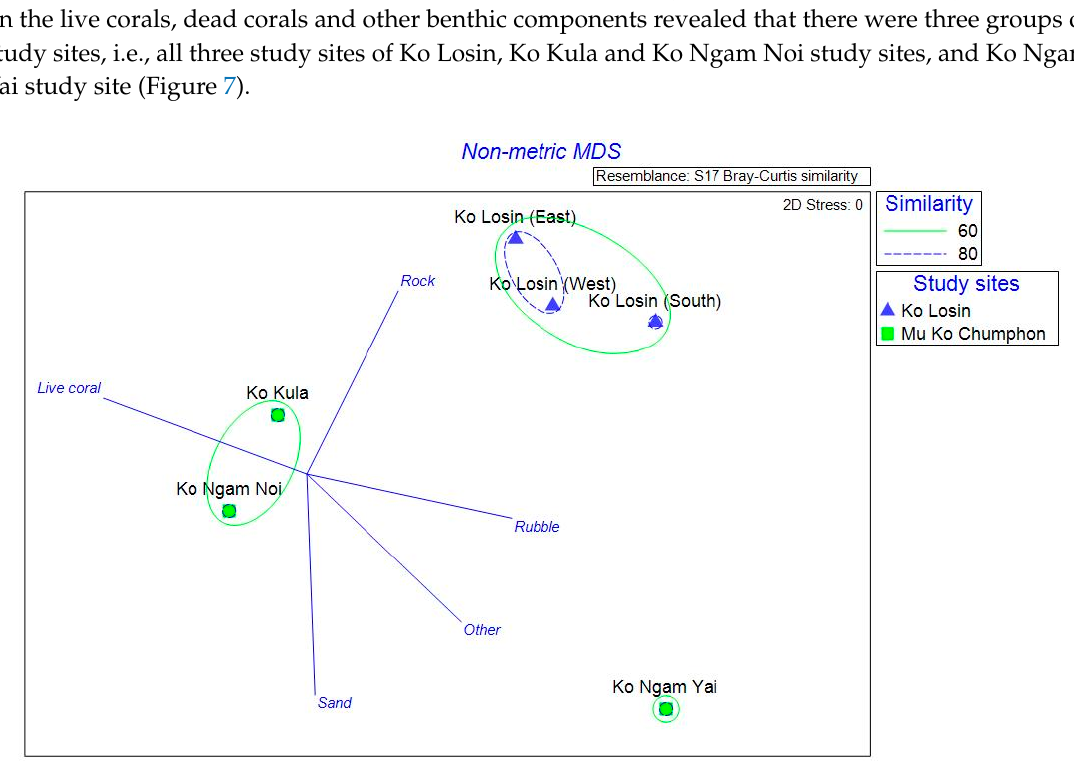
Figure 7. Two-dimensional NMDS plot of the study sites.